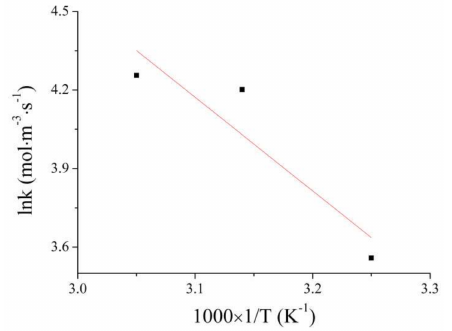
Figure 7. Arrhenius